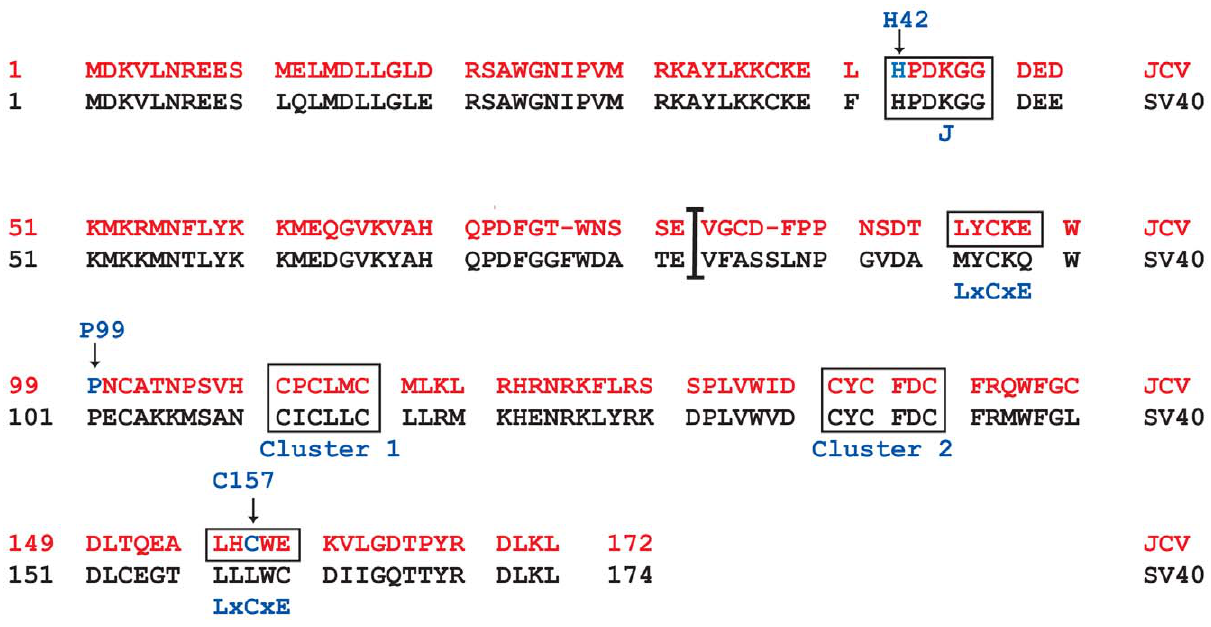
Figure 2. Comparison of JCV and SV40 tAg amino acid sequences. The JCV tAg sequence containing 172 amino acids is indicated in red letters, and the 174 amino acid SV40 tAg is shown in black letters. The sequences following the vertical line comprise the unique C-terminal region of each protein. Two conserved cysteine (CxCxxC) clusters (Cluster 1, 2) that contribute to SV40 tAg binding to zinc ions, and possibly to PP2A, are noted in both sequences, as are two recently recognized LxCxE motifs in JCV tAg. Three amino acid residues are highlighted with a blue letter and arrow. Histidine 42 (H42) is a conserved residue in the HPDKGG hexapeptide motif of the J domain that spans most of the N-terminal region of tAg as well as the other JCV and SV40 early proteins; H42 is required for functional interaction with Hsc70. Proline 99 is within a conserved CxxxPxC sequence that influences SV40 tAg binding to PP2A. Cysteine 157 is the central residue of the newly recognized second LxCxE motif in JCV tAg.